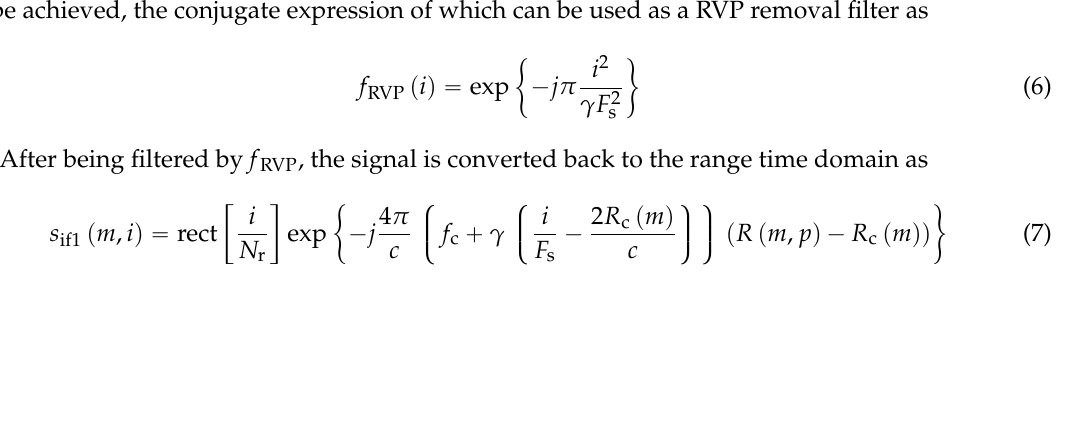
f RVP Figure 3. Flowchart of the RVP removal manipulation.